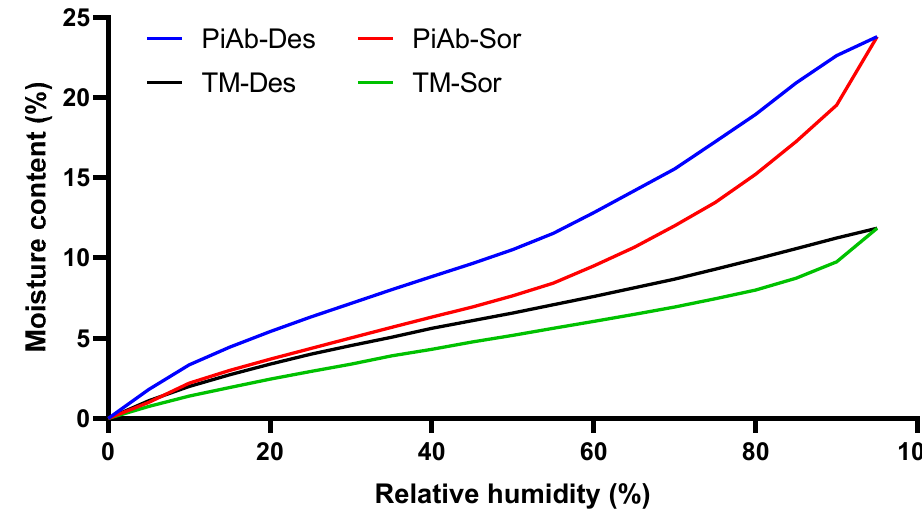
Figure 5. Relationship between relative humidity and wood moisture content, as determined with DVS for Norway spruce (PiAb) and thermally modified Norway spruce (TM) in sorption (Sor) and desorption (Des) cycles.